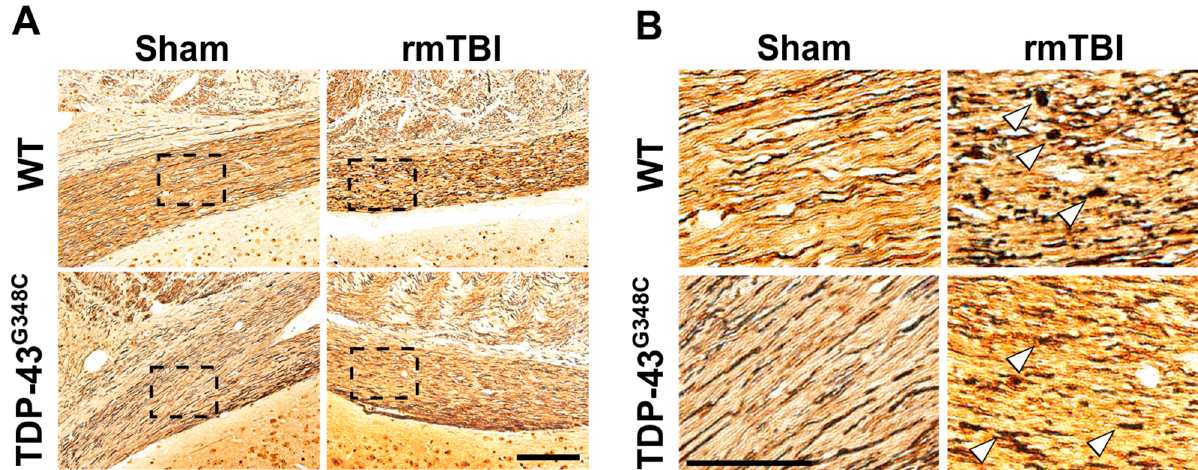
Figure 2. Axonal degeneration in the optic tract (OT) of wild-type (WT) and TDP-43 G348C mice at 6 months after repetitive mild traumatic brain injury (rmTBI). ( A ) Representative microphotographs of the OT stained with the silver staining in the mice of the control group (Sham) and the animals with rmTBI. Scale bar: 200 μ m. ( B ) Microphotographs are higher-magnification images of the areas in the boxes of the corresponding panels. Arrowheads point to the spheroids of degenerating axons. Scale bar: 50 μ m.